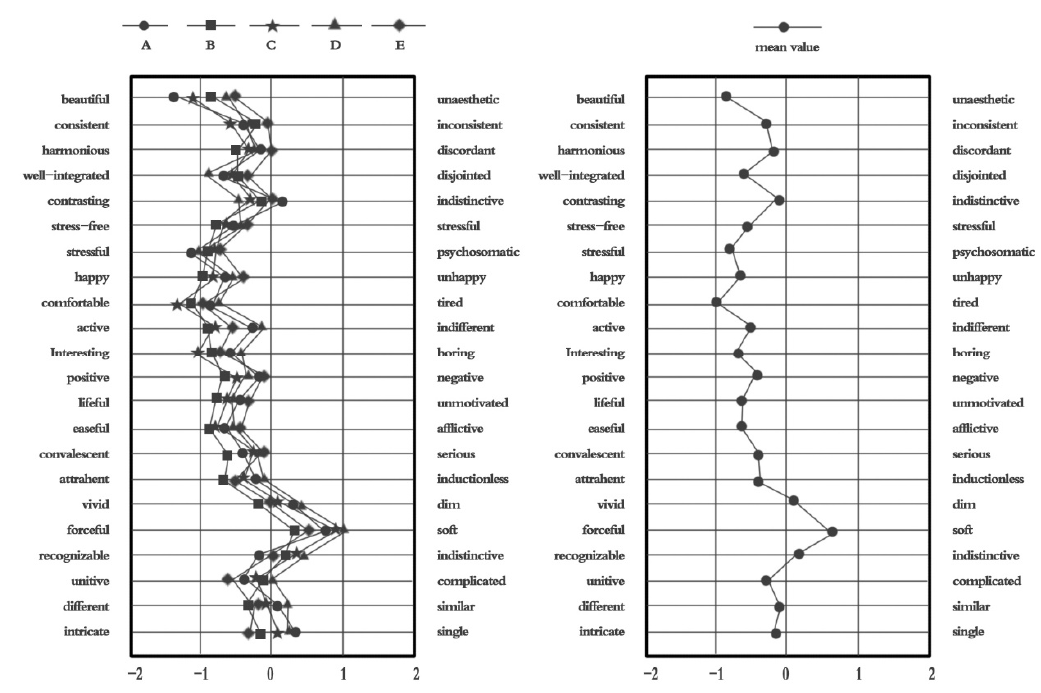
Figure 4. SD curve of the evaluation of blue space in the Yijie